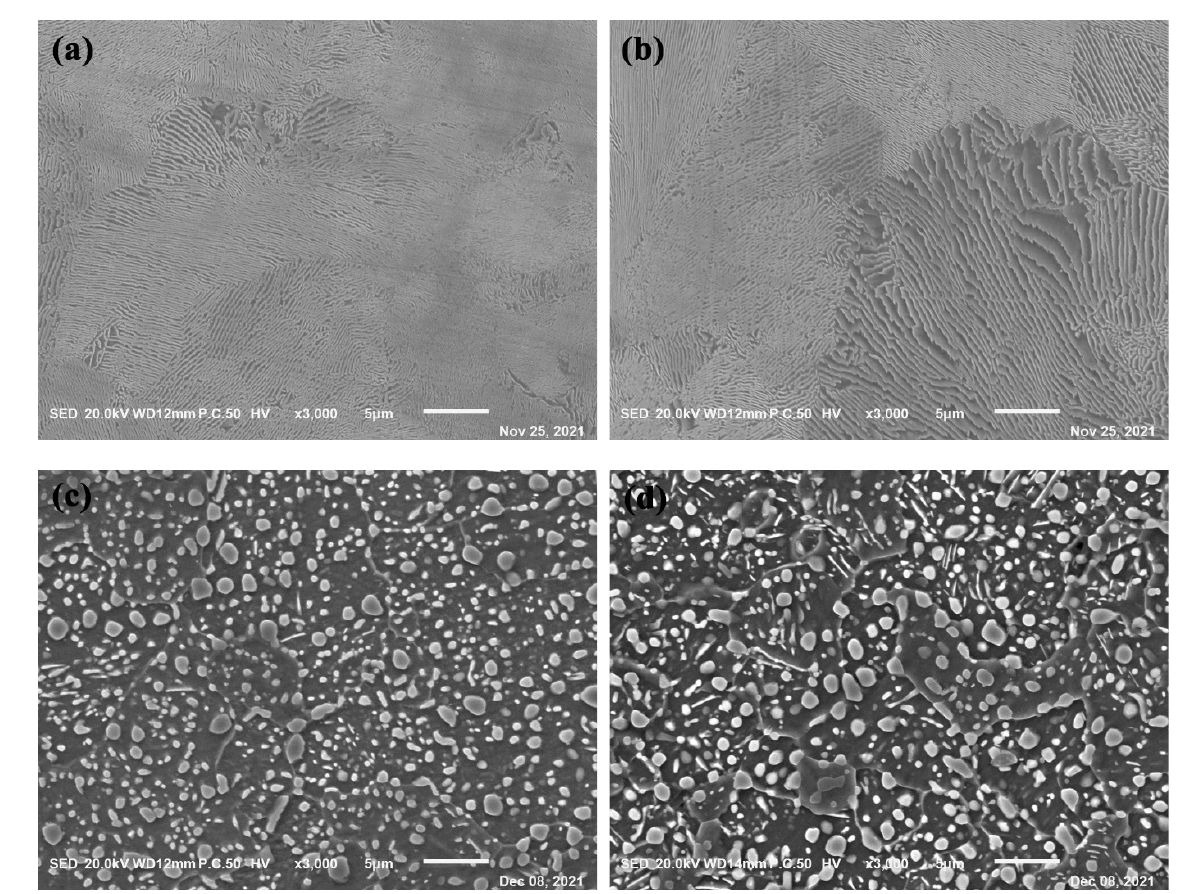
Figure 3. SEM images of experimental steels before and after spheroidizing annealing treatments: ( a ) GCr15SiMo and ( b ) GCr15Si1Mo before spheroidizing annealing treatments; ( c ) GCr15SiMo and ( d ) GCr15Si1Mo after spheroidizing annealing treatments.